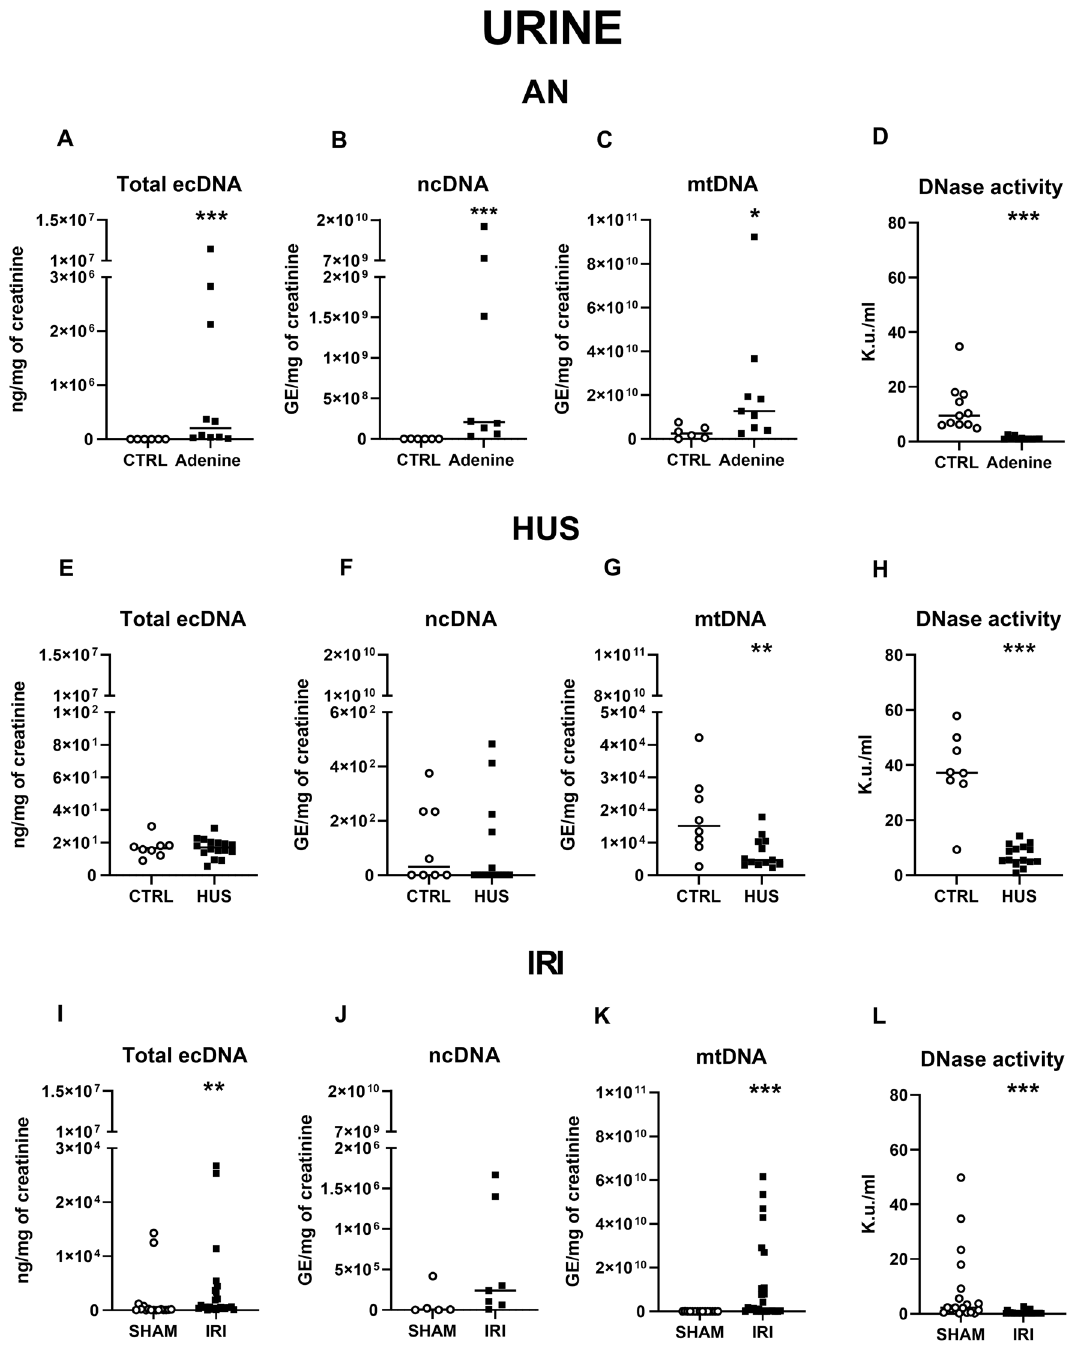
Figure 3. Concentrations of urinary ecDNA, its subtypes and DNase activity in different animal models of AKI. Urinary ( A ) total ecDNA, ( B ) ncDNA, ( C ) mtDNA, ( D ) Dnase activity in AN and healthy mice. Urinary ( E ) total ecDNA, ( F ) ncDNA, ( G ) mtDNA, ( H ) DNase activity in animals with HUS and controls. Urinary ( I ) total ecDNA, ( J ) ncDNA, ( K ) mtDNA, ( L ) DNase activity in IRI rats and sham animals. Results are presented by individual values plots with median. * denotes p ˂ 0.05, ** denotes p ˂ 0.01, *** denotes p ˂ 0.001 in comparison to healthy controls or sham animals, respectively. AN adenine nephropathy, DNase deoxyribonuclease, ecDNA extracellular DNA, HUS haemolytic uremic syndrome, IRI ischemia–reperfusion injury, mtDNA mitochondrial DNA, ncDNA nuclear